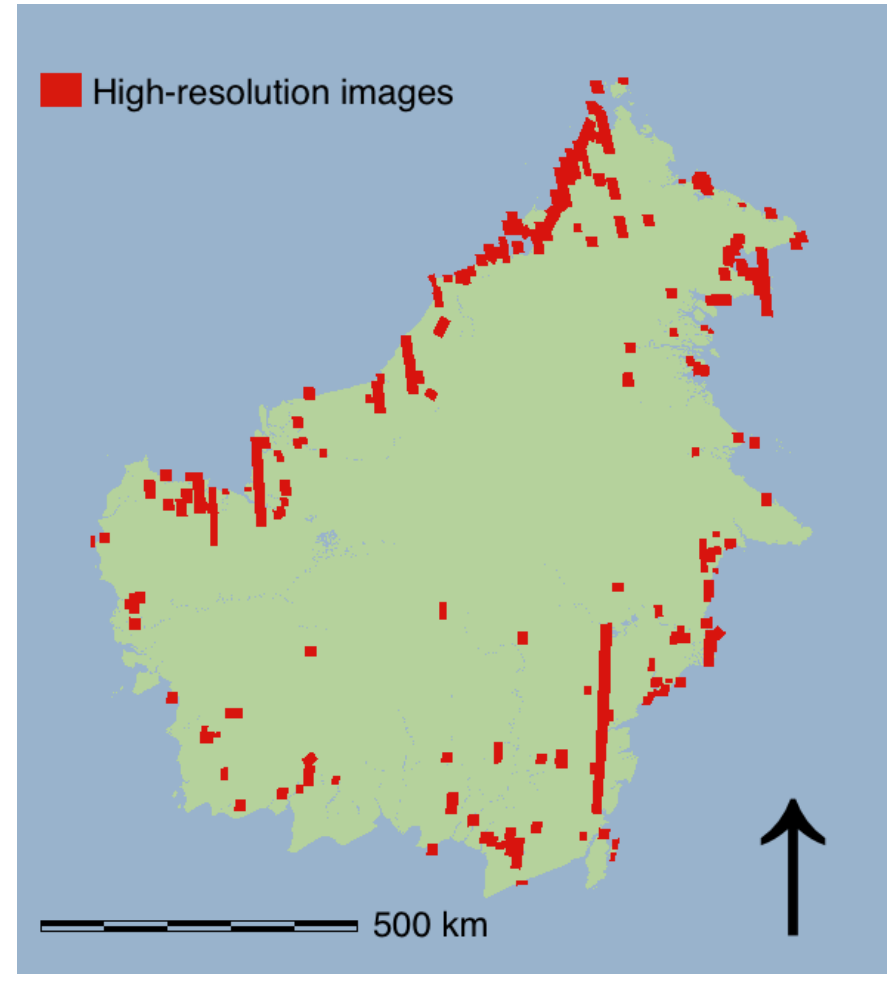
Figure 1. Island of Borneo showing location of Google Earth high-resolution imagery from between 2000 and 2009.